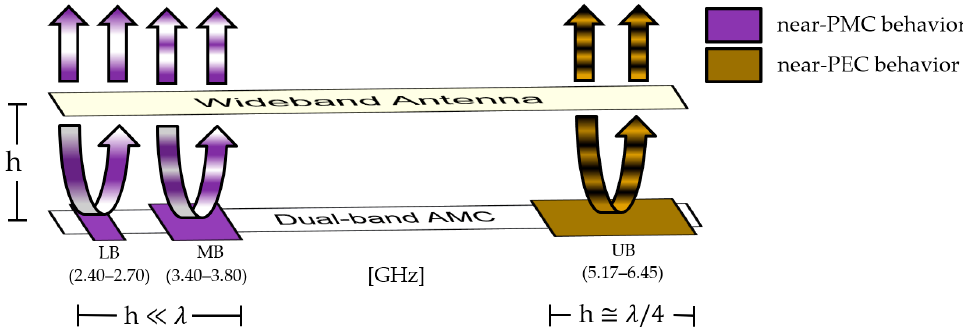
Figure 2. Working principle: the dual-band AMC works as a near-PMC reflector around two resonances and as a near-PEC reflector far from resonances.